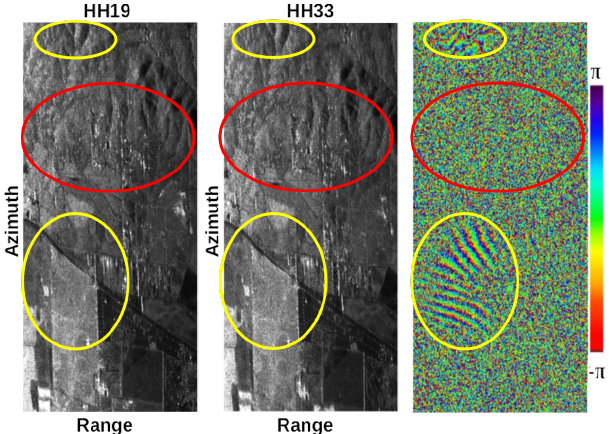
Figure 4. SLC amplitude images relevant to the tracks 19 and 33 and the resulting